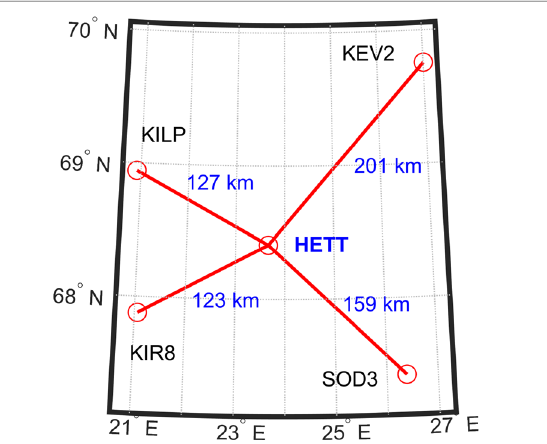
Fig. 5 Baselines and stations employed in the experiment. HETT served as a rover receiver, whereas KILP, KEV2, SOD3 and KIR8 were used as the reference stations